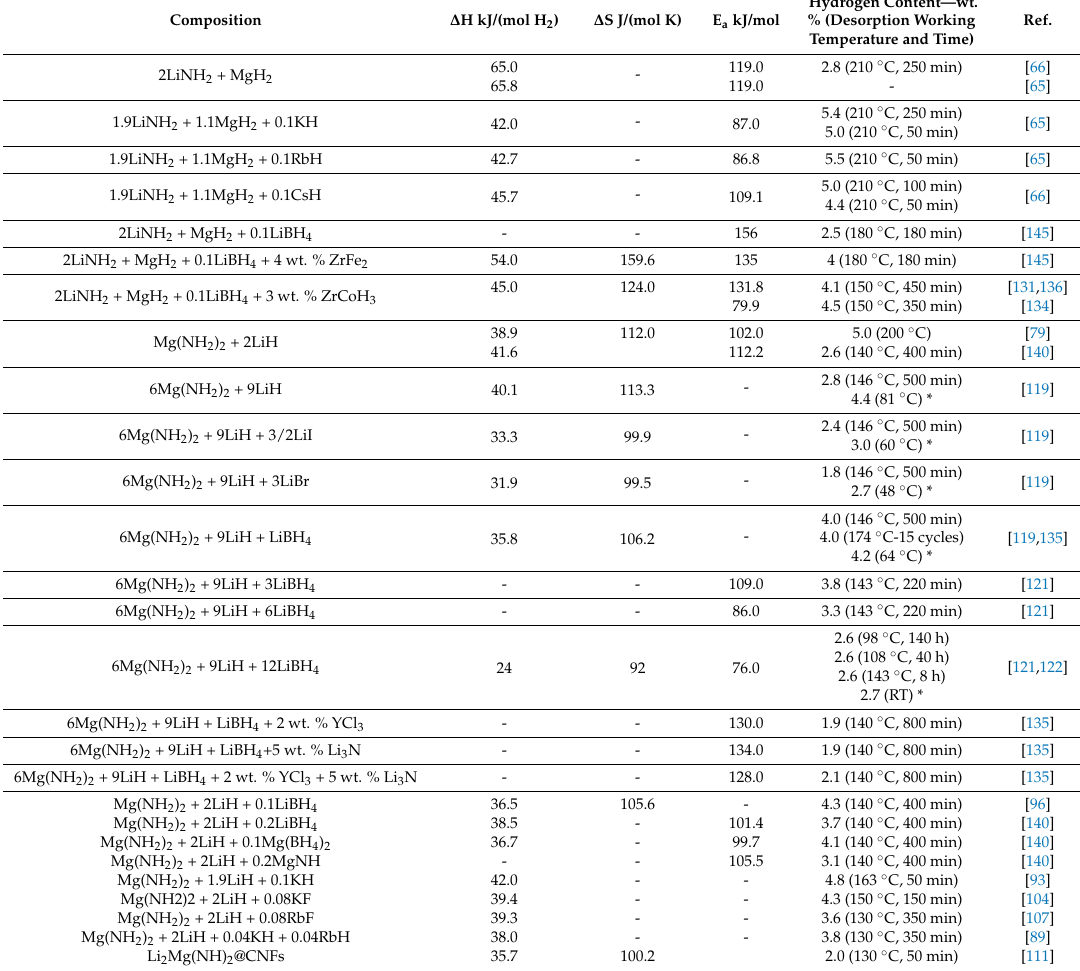
* theoretical dehydrogenation temperature over 0.1 MPa equilibrium hydrogen